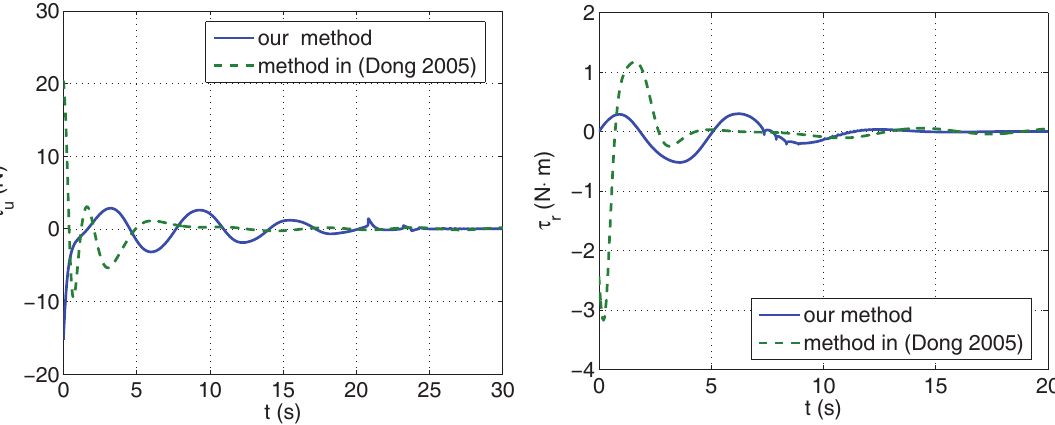
Figure 6. Comparison of surge force τ u and yaw torque τ r of this paper and [12].